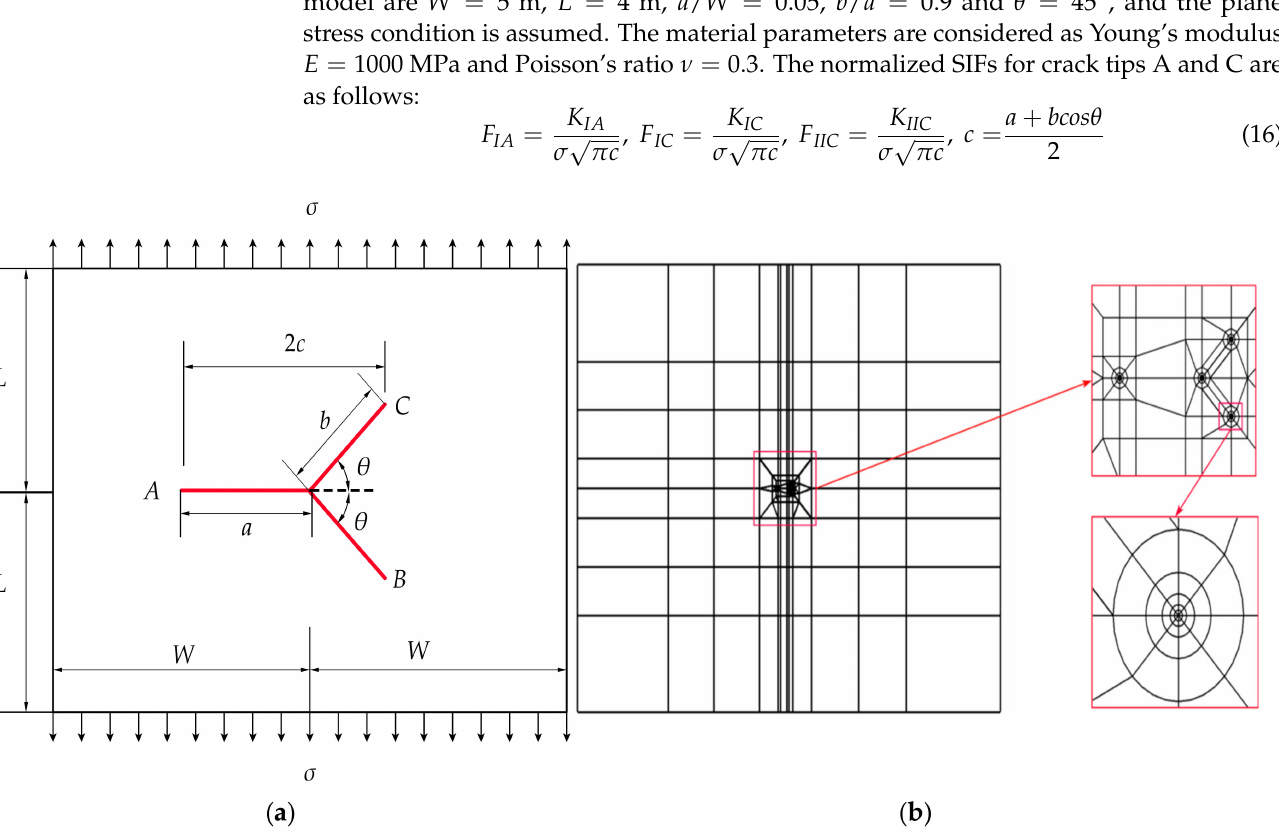
Figure 9. ( a ) A branched crack in an infinite plate; ( b ) Global and local meshes (the total number of elements is